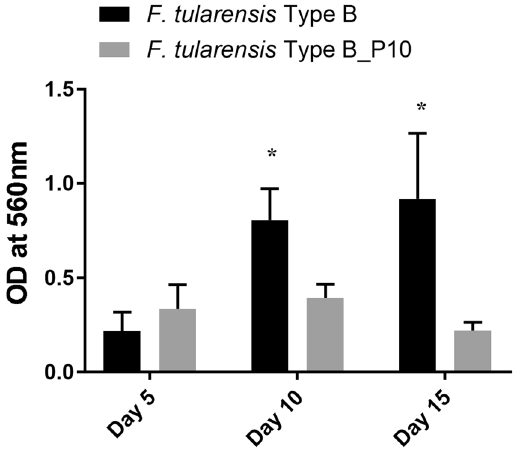
Figure 3. Biofilm formation by a F . tularensis subspecies holarctica wildtype strain following subculture passage in CDMB. A wildtype Type B strain was incubated in microtiter plates under biofilm forming conditions before and after 10 daily subculture passages in CDMB. After 5, 10, or 15 days incubation the wells were rinsed to remove planktonic cells, stained with CV, and the CV solubilized with ethanol and the absorbance determined at 560 nm. Five to six replicates of the parent and the passed variant were tested at each time period. * Indicates a statistically significant difference ( P <